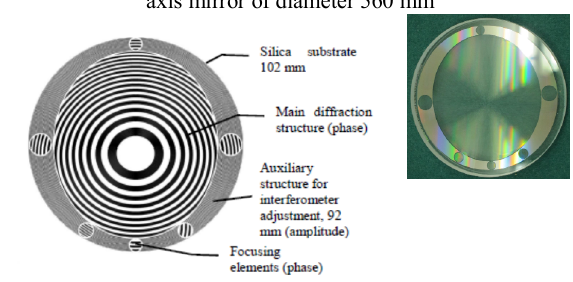
Fig. 2. CGH for off-axis mirror